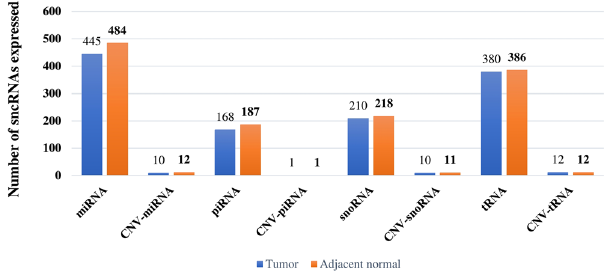
Figure 3. Expression profiles of small non-coding RNAs in breast tumor and adjacent normal tissues (HiSeq). Figure illustrates the expression profiles from the four classes of sncRNAs between tumor and adjacent normal tissues. Individual bar graphs capture the expressed total sncRNAs and CNV-sncRNAs. Data presented is from TCGA Illumina Hiseq (n = 254 cases and 18 adjacent